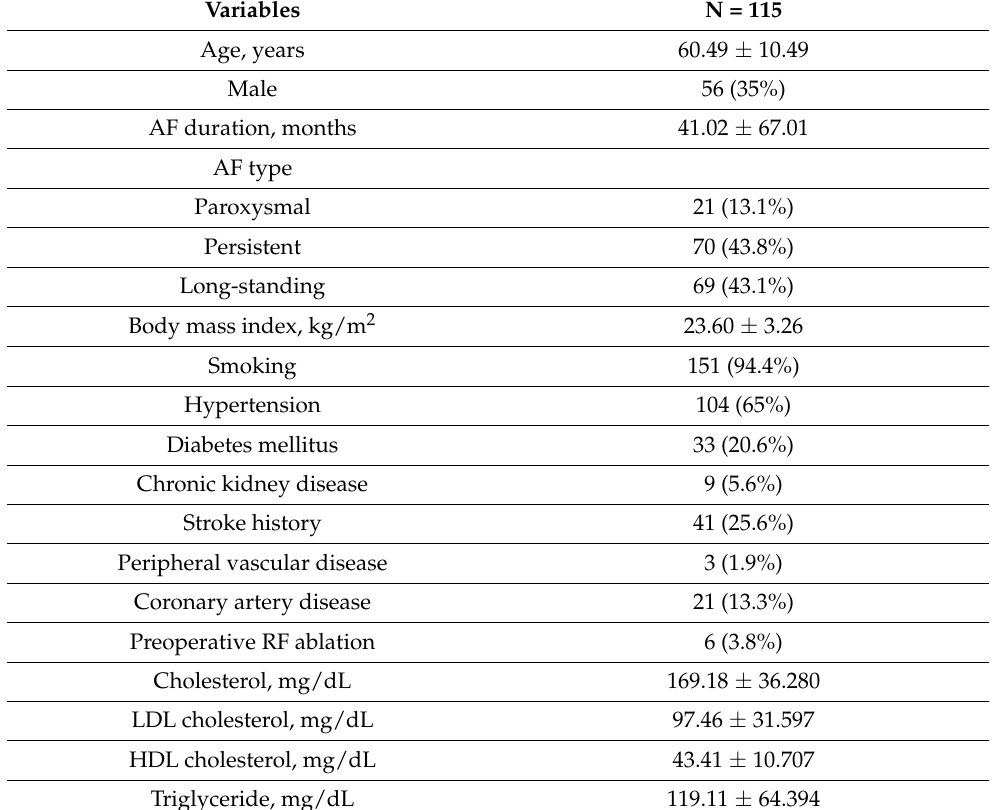
Table 1. Patients’ preoperative